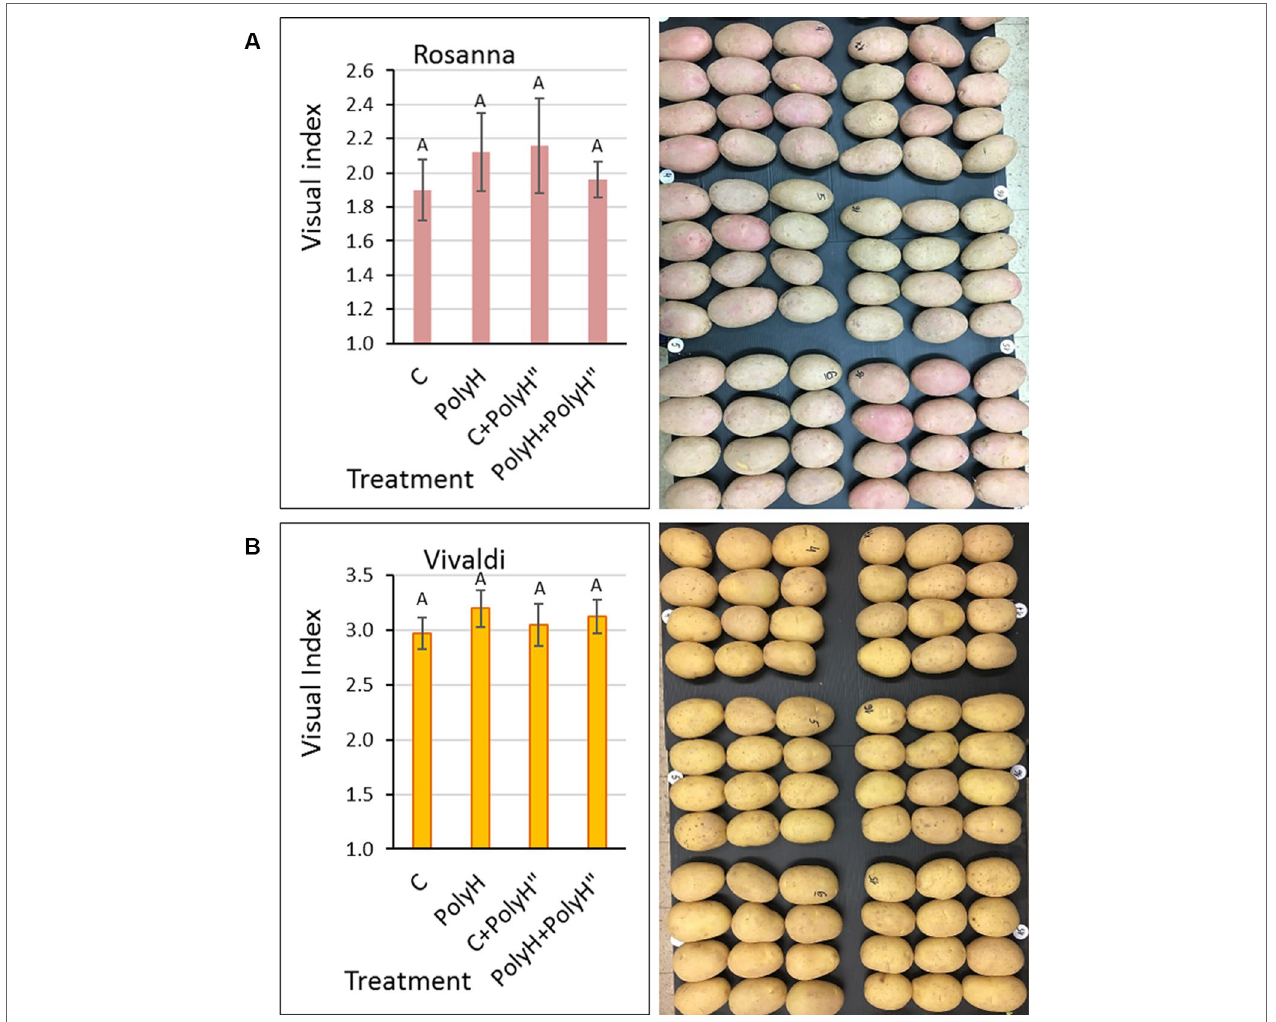
FIgURE 7 | Evaluation of skin appearance of Rosanna (a) and Vivaldi (B) tubers from experiment 3. Sample labeling and treatments are as described in Figures 5 and 6 . Visual evaluation of tuber appearance was performed after 2 months of storage (left panels). Values are averages of five replicates with SE. Visual index and assessment were as described in Figure 2 . Data were not significant by Student’s t -test. Right panels demonstrate the problem of low skin quality and poor tuber appearance, irrespective of the polyhalite treatments. Rosanna tubers exhibited russeted skin with gray or faint pink color instead of the desired shiny appearance with dark-pink pigmentation. Tubers of Vivaldi exhibited russeted skin with brownish tint instead of the desired shiny yellow